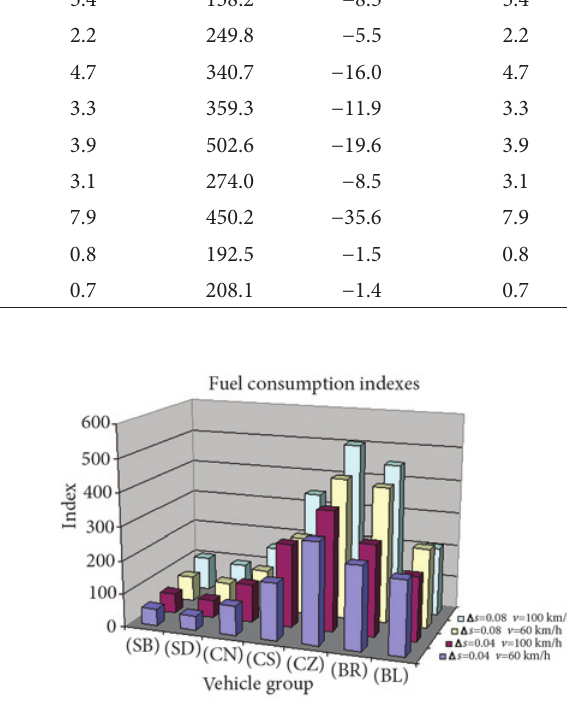
Fig. 14. Fuel consumption indexes calculated on the basis of (11)